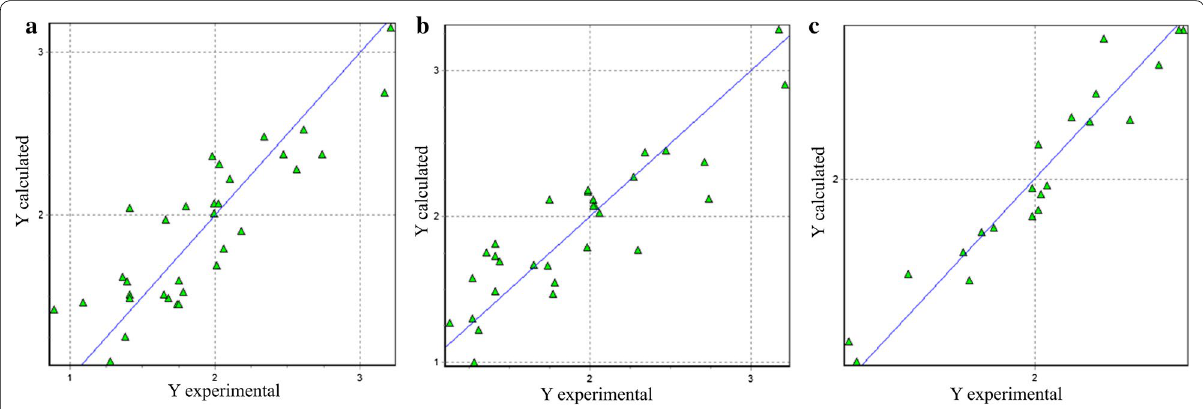
Fig. 3 Predicted versus experimental larvicidal activity from property–activity relationship models. a Model 1, b model 3, c model